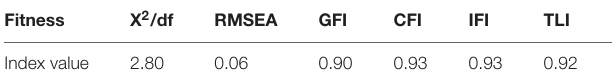
TABLE 4 | Test of theoretical model fitting. TABLE 5 | Test of basic hypothesis.